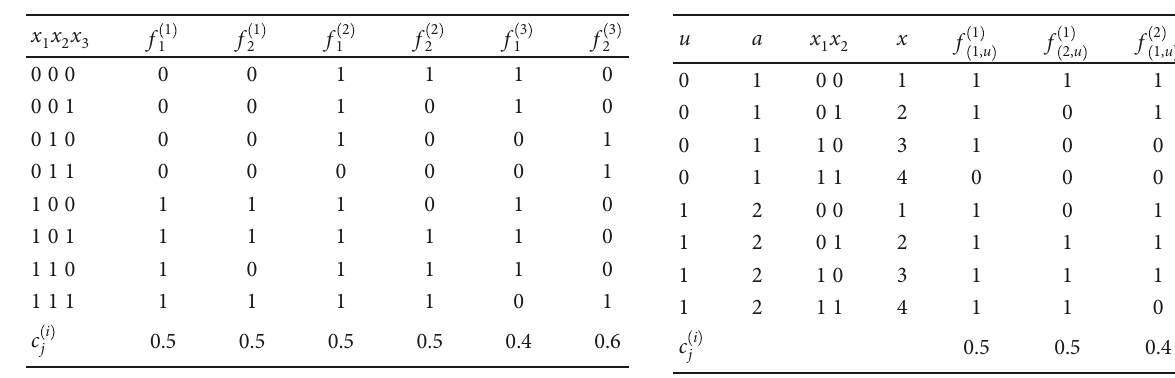
Table 1: Truth table. Table 2: Truth